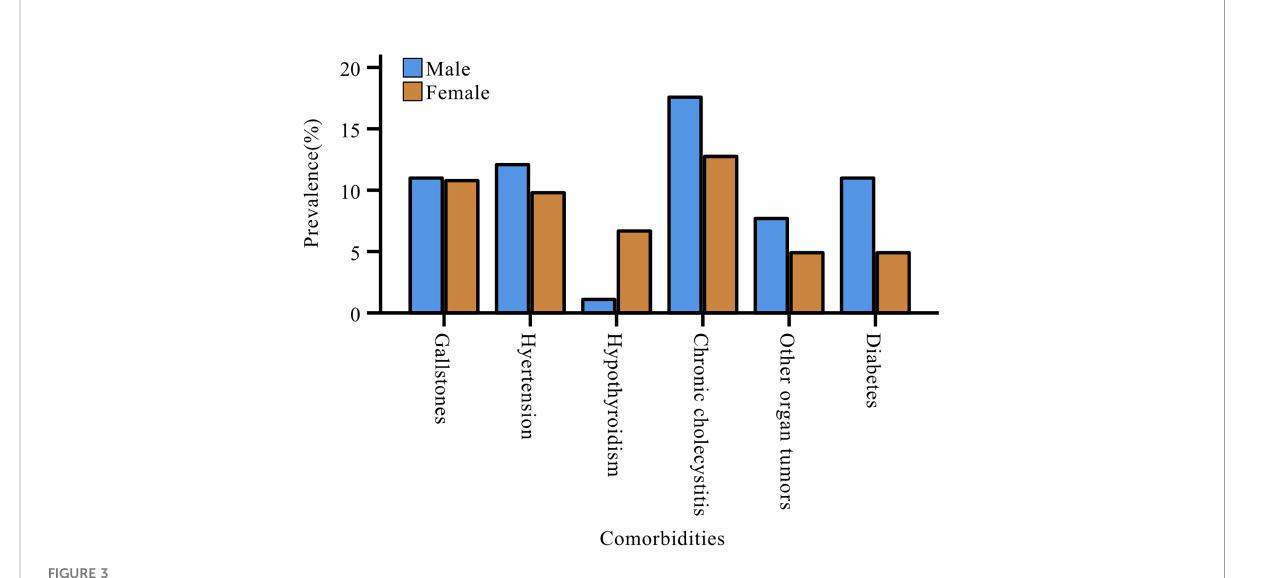
FIGURE 3 Gender differences in comorbidities of patients with pNENs.